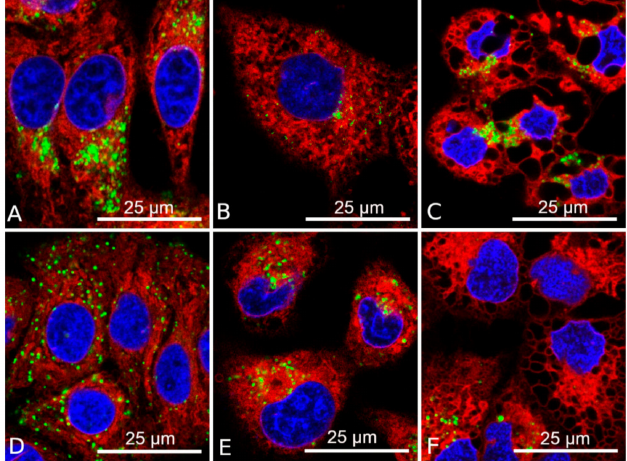
Figure 5. Confocal microscopy images of ER-mediated vacuolization of НЕр- 2 ( a – c ) and A549 ( d – f ) cells after 6 h of incubation with 1 mM DDC + 25 µ M B 12b . ( a ), ( d ) control cells; ( b ), ( e ) cells incubated for 6 h with 1 mM DDC; ( c ), ( f ) cells incubated for 6 h with DDC + B 12b . Staining with H342 (1 µ g / mL), ER-Tracker Red (1 µ M), and LysoTracker Green (0.2 µ